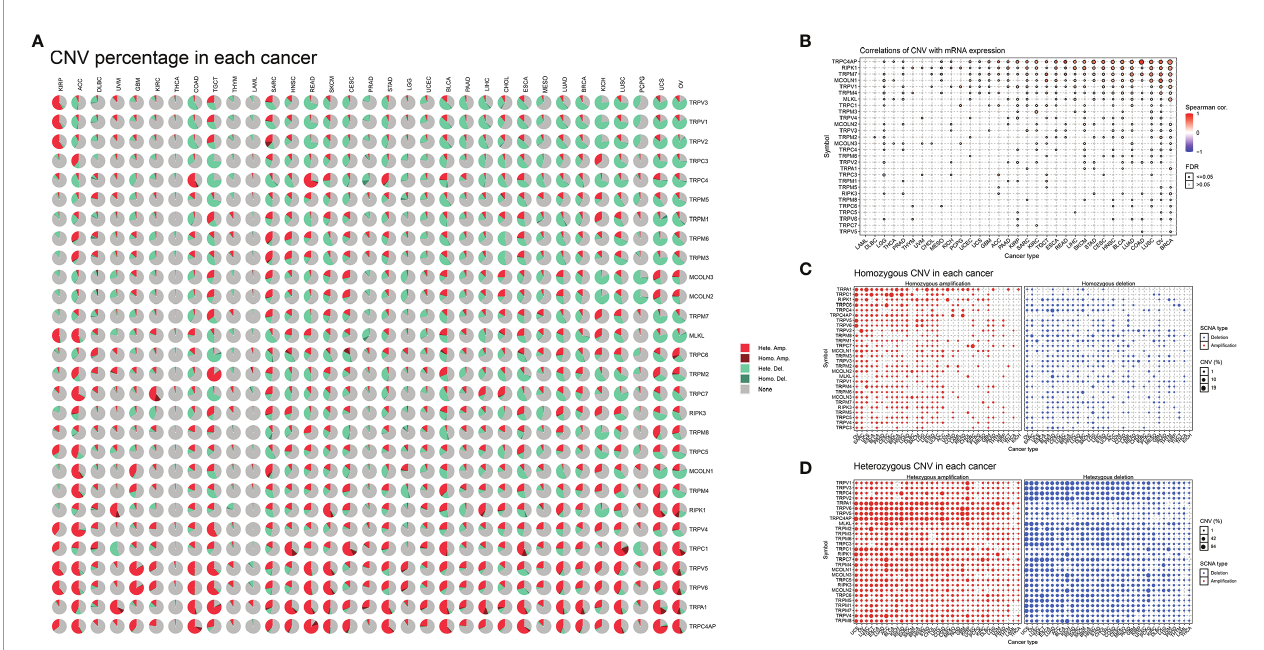
FIGURE 6 | The CNV of TRP family genes in pan-cancer. (A) Pie plot summarising the CNV of TRP family genes in indicated tumour types. (B) The correlation between CNV with gene expression. (C) The homozygous CNV pro fi le shows the percentage of homozygous CNV, including the percentage of homozygous ampli fi cation and deletion for each TRP family gene in each cancer. (D) The heterozygous CNV pro fi le shows the percentage of heterozygous CNV, including the percentage of heterozygous ampli fi cation and deletion for each TRP family gene in each